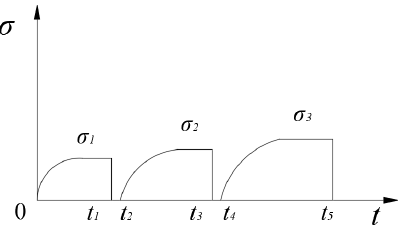
Figure 5. The proposed loading mode of the triaxial creep experiment.